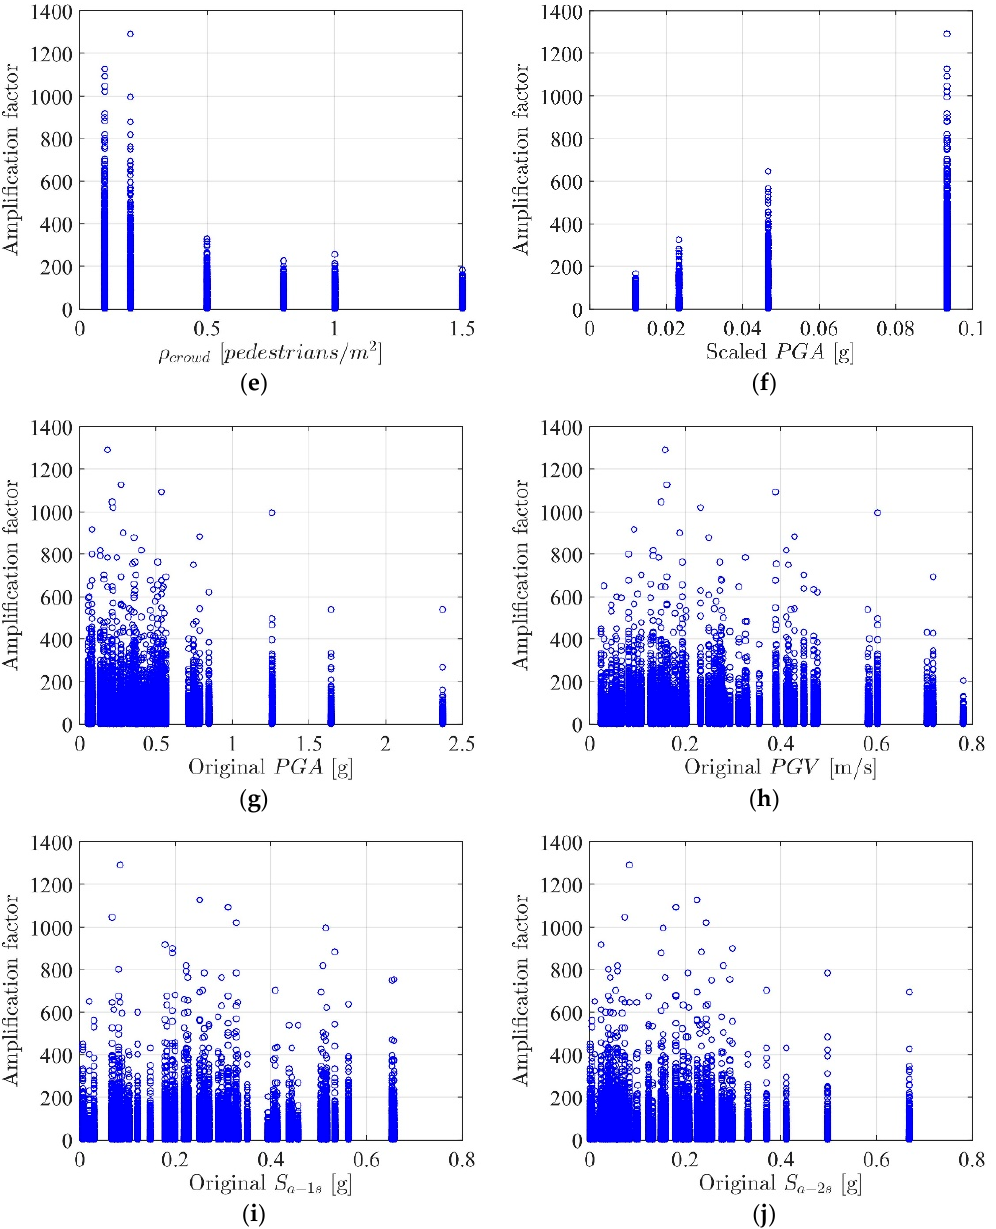
Figure 16. Relationship between the amplification factor and 10 input variables. ( a ) Input 1, ( b ) Input 2, ( c ) Input 3, ( d ) Input 4, ( e ) Input 5, ( f ) Input 6, ( g ) Input 7, ( h ) Input 8, ( i ) Input 9, ( j ) Input 10.